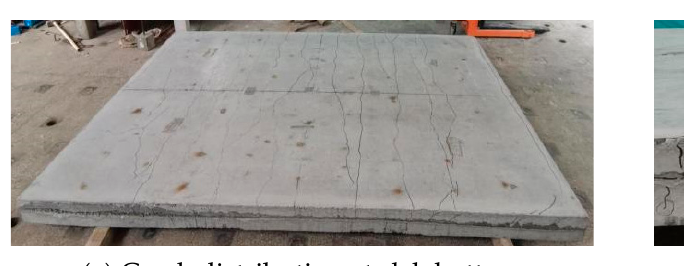
Figure 11. Failure mode and crack distribution of DBD01.